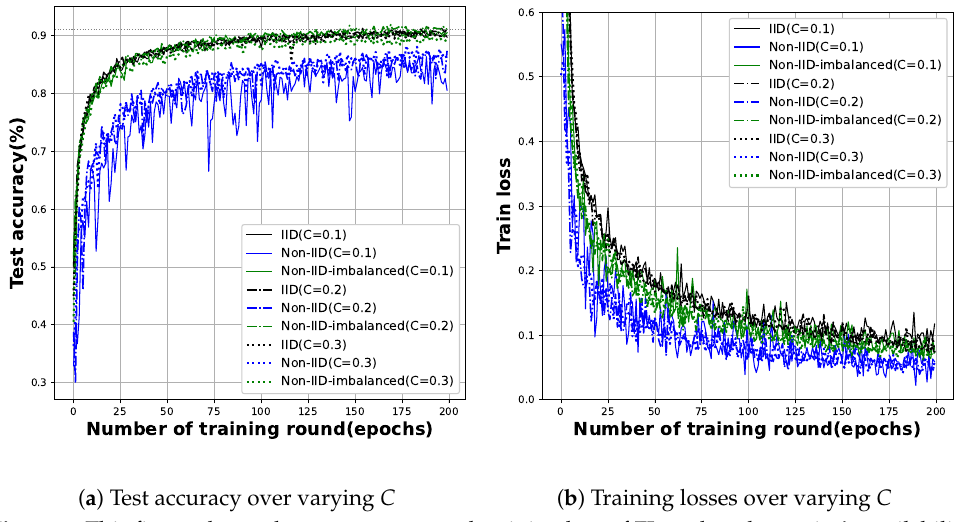
Figure 5. This figure shows the test accuracy and training loss of FL as the edge entity’s availability ( C ) varies under three different data distributions.